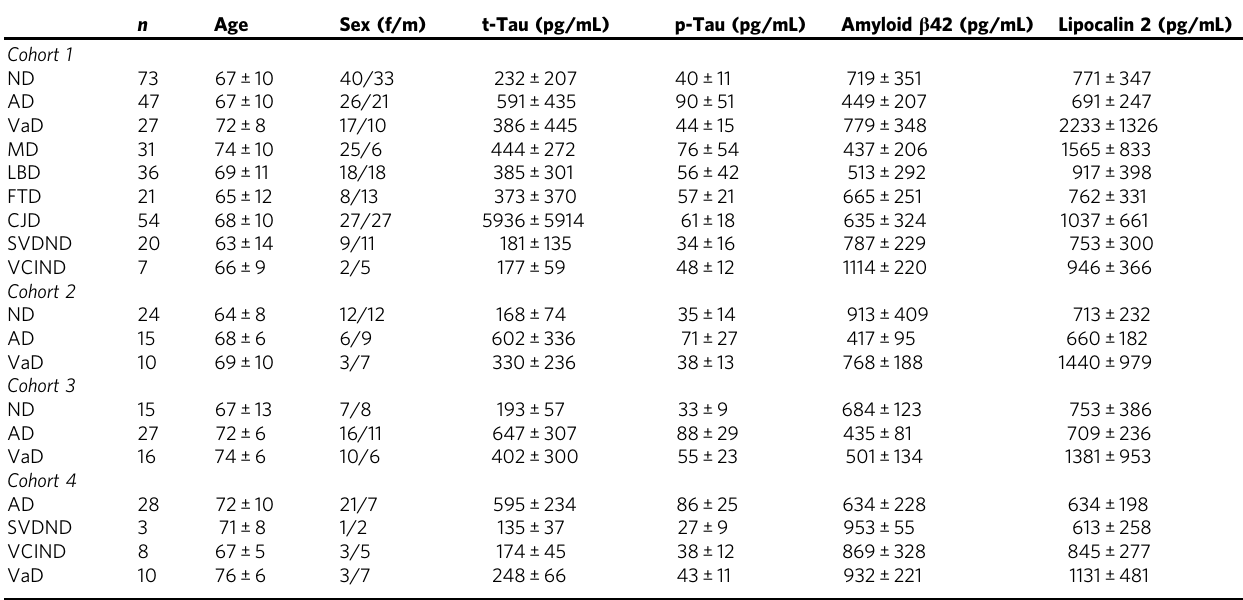
Table 1 Demographics and biomarkers data from the different cohorts.